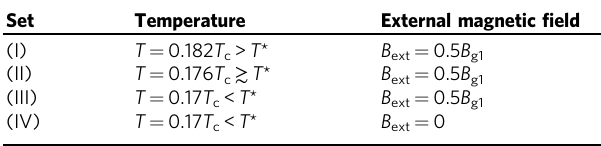
Table 1 Sets of parameters used for presenting results Set Temperature External magnetic fi eld